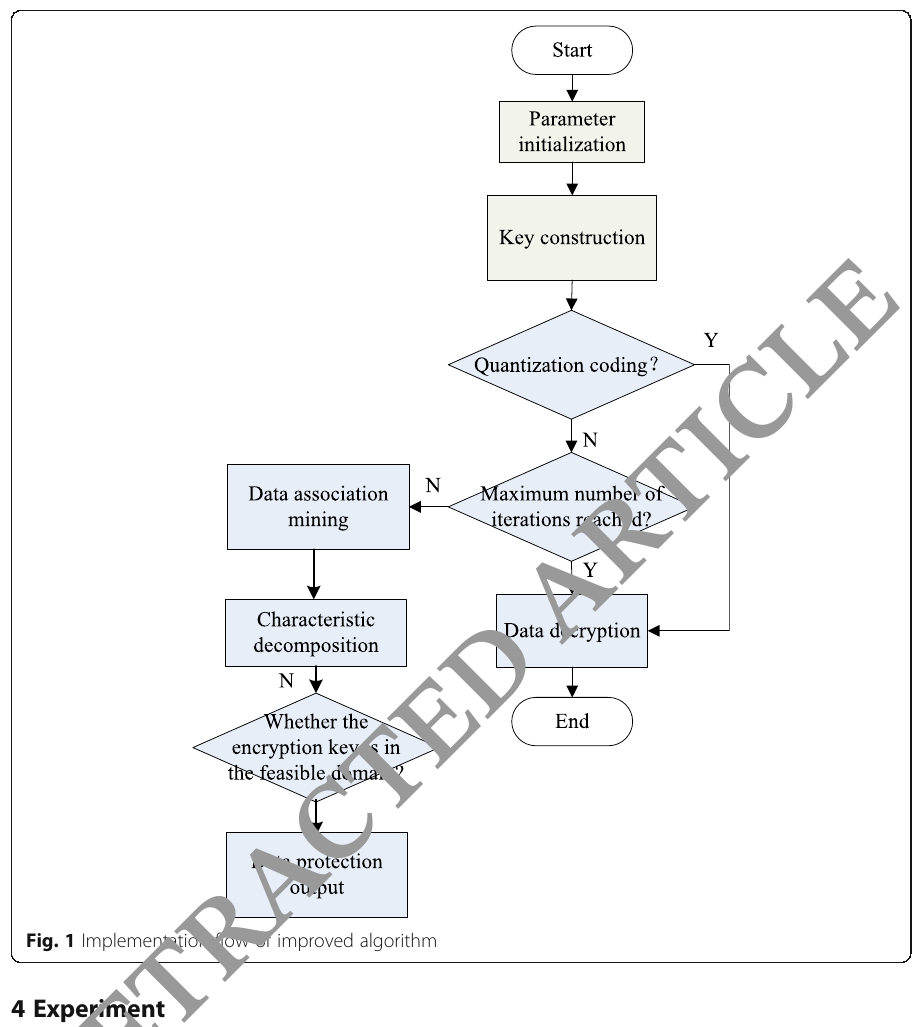
Fig. 1 Implementation flow of improved